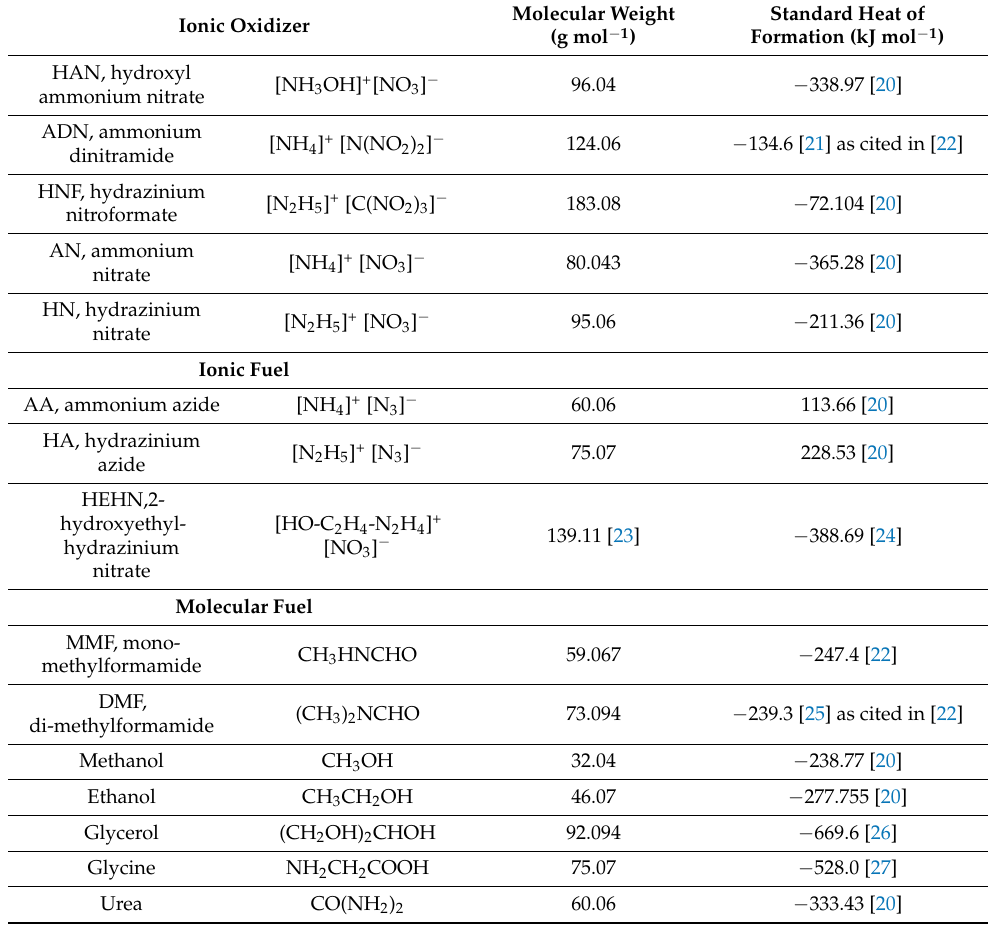
Table 1. Energetic ionic liquids: oxidizers and fuels thermochemical properties [8,16–19].